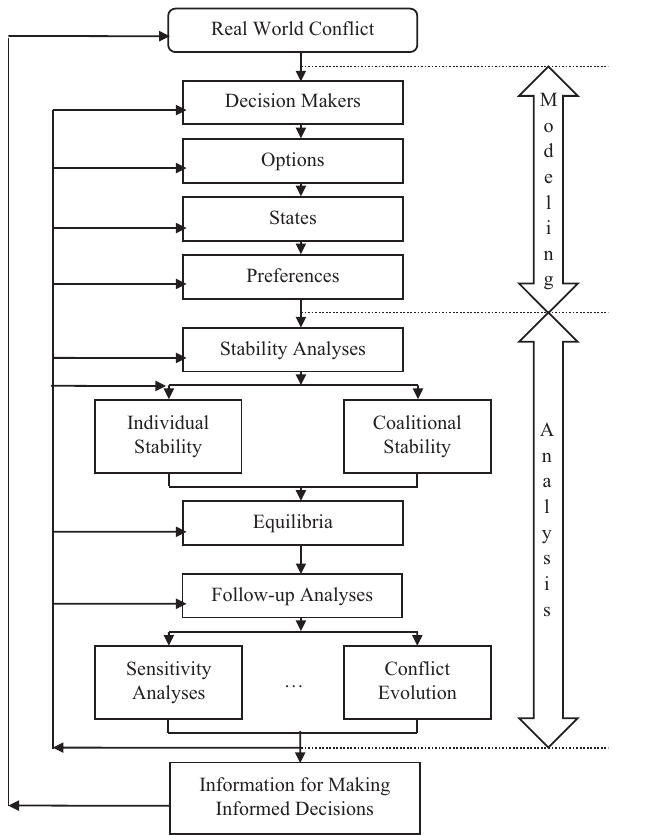
Figure 3. Main components of the graph model for conflict resolution